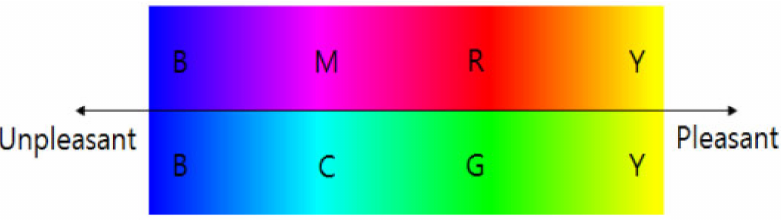
Figure 6. Mapping the 6 colors into the X-axis of “Unpleasant-Pleasant”